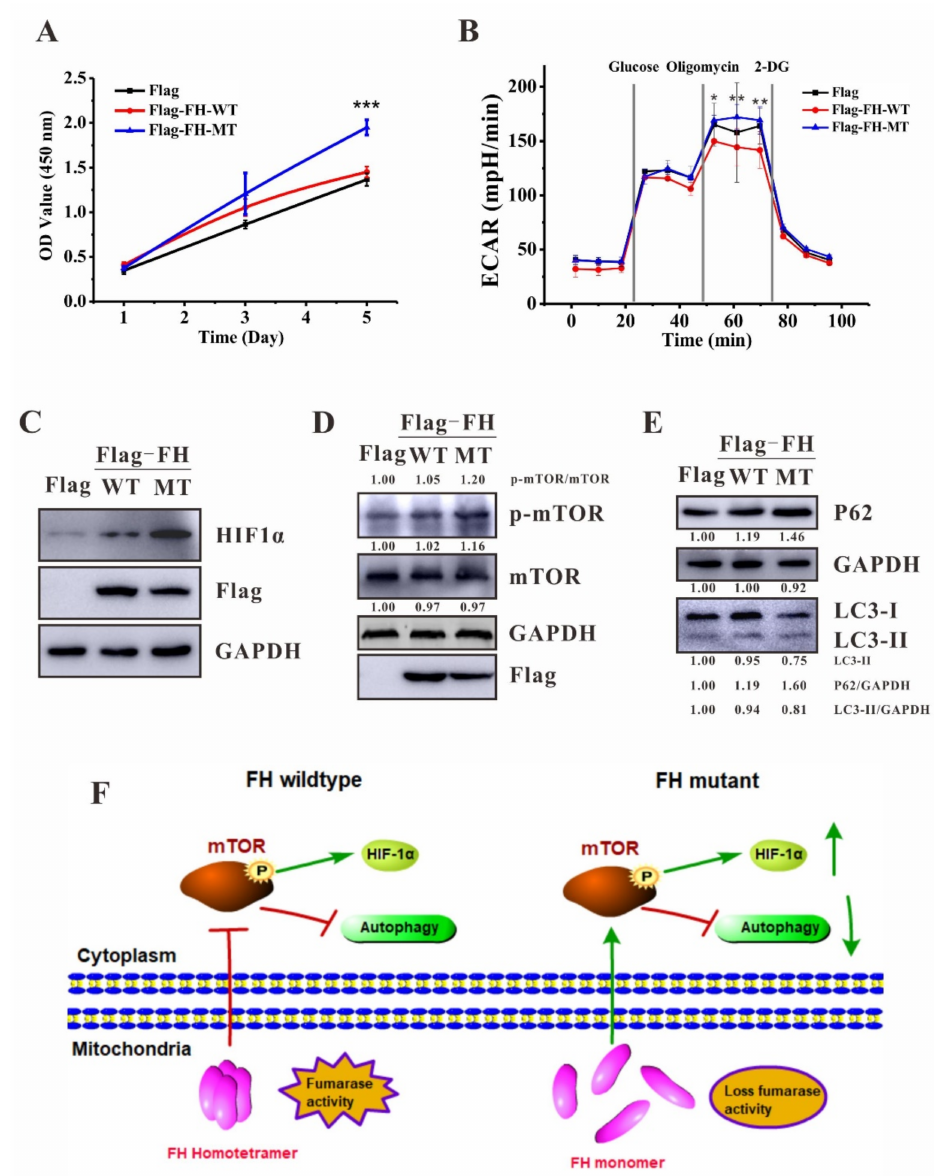
Figure 4. Dysregulation in mTOR signaling and Autophagy. ( A ) Cell proliferation of Flag only, Flag-FH wildtype or Flag-FH mutant overexpression HEK293T cells. The significance between Flag- FH-WT and Flag-FH-MT was indicated (*** p < 0.001). ( B ) Extracellular acidification rate (ECAR) was measured after consecutive injections of glucose (10 mM), oligomycin (1 µ M), and 2-DG (50 mM) in stable cell lines. The significances between Flag-FH-WT and Flag-FH-MT were indicated (* p < 0.05; ** p < 0.01). ( C ) HIF-1 α was analyzed by western blotting in stable cell lines upon treatment with MG132 at a final concentration of 10 nM for overnight. ( D ) Western blotting for mTOR activation on stable cell lines. ( E )The expressions of LC3-II and p62 were measured in stable cell lines. GAPDH was used as an internal loading control. All data are presented as the mean ± SD from at least three separate experiments. ( F ) Proposed mechanism of FH mutation results in uterine leiomyomas. In the presence of FH wildtype, fumarase homotetramer is formed to exhibit the enzyme activity, resulting in the inhibition of mTOR signaling. In the presence of FH mutant, fumarase homotetramer is impaired and the enzyme activity is lost, resulting in the activation of mTOR, which further leads to the upregulation of HIF-1 α and downregulation of